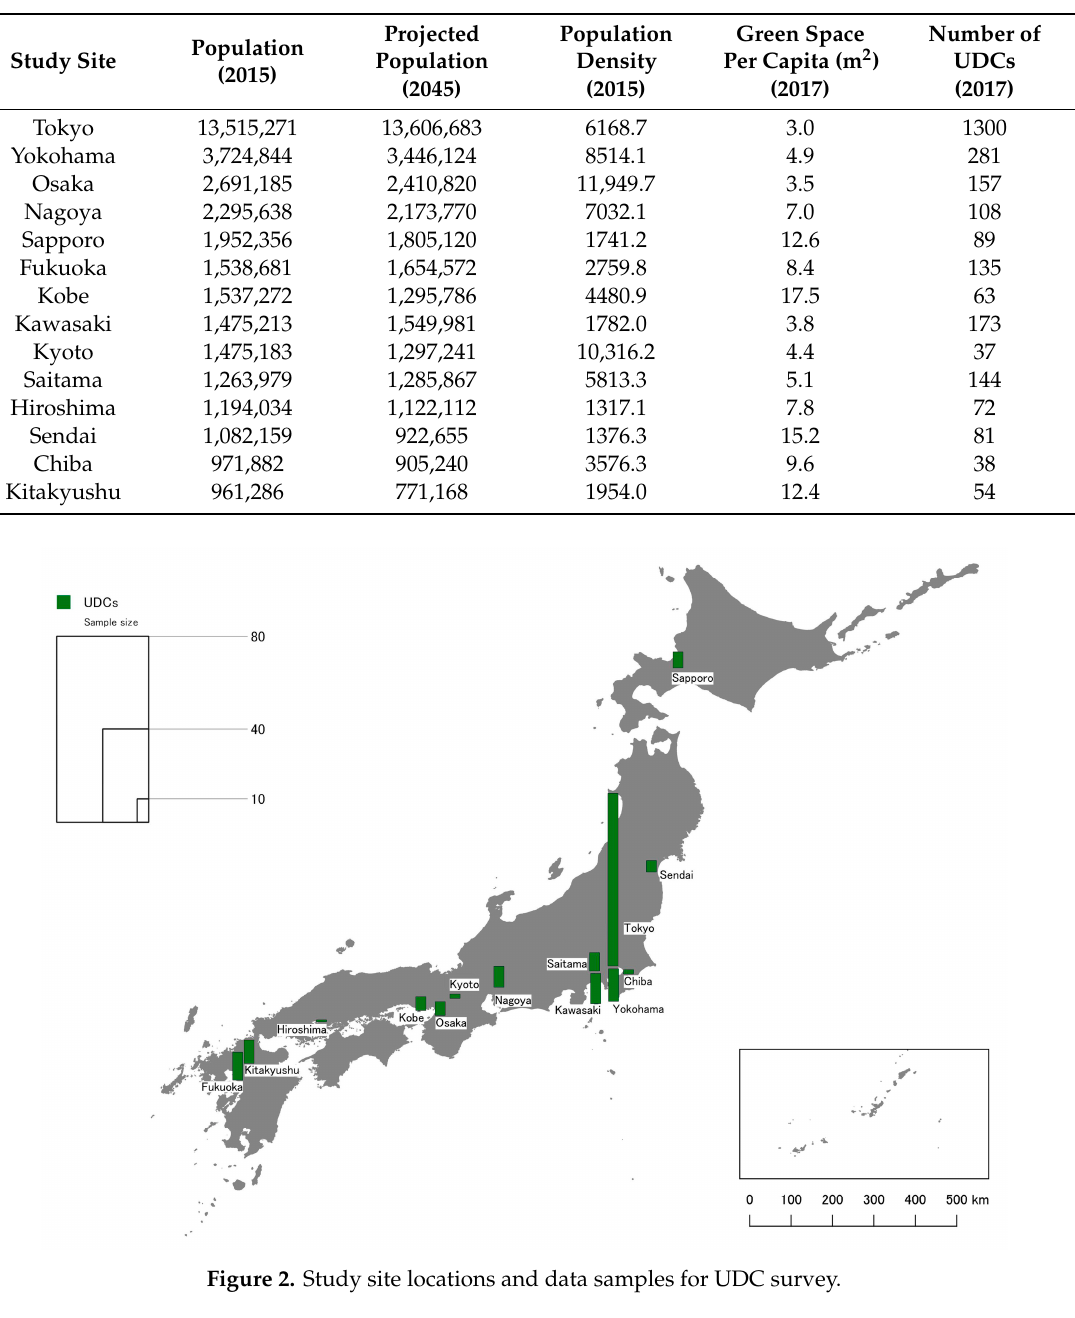
Figure 3. Study site location and samples for the parent survey.